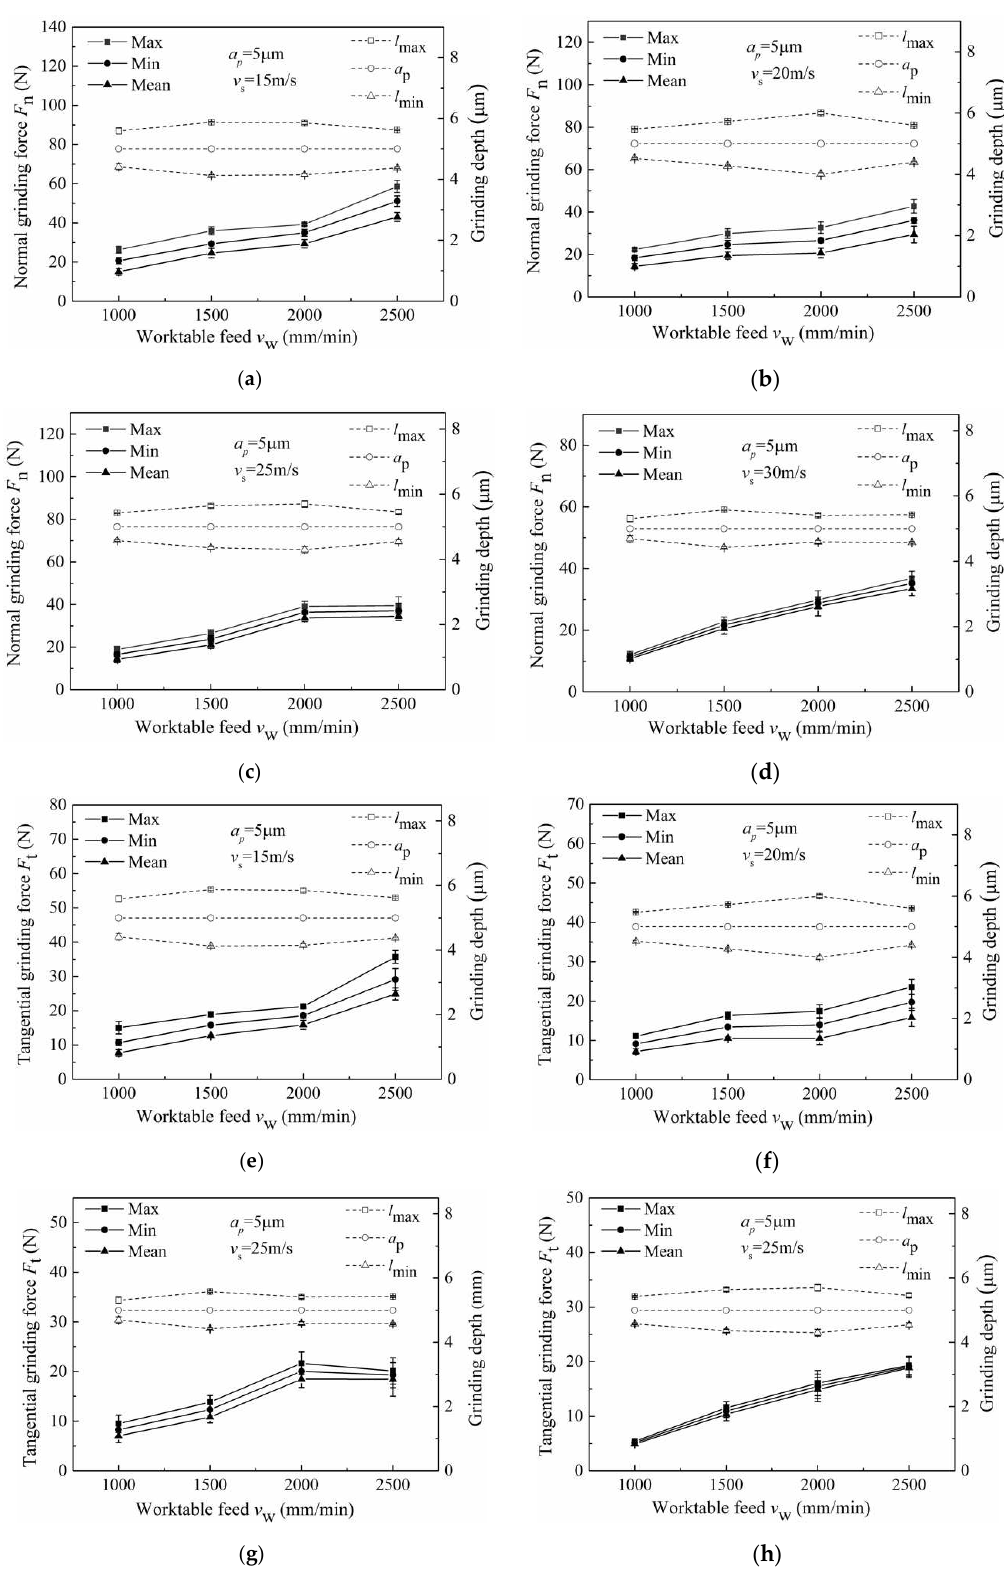
Figure 9. Influence of worktable feed on ( a – d ) normal grinding force and grinding depth and ( e – h ) tangential grinding force and grinding depth. ( e – h ) tangential grinding force and grinding